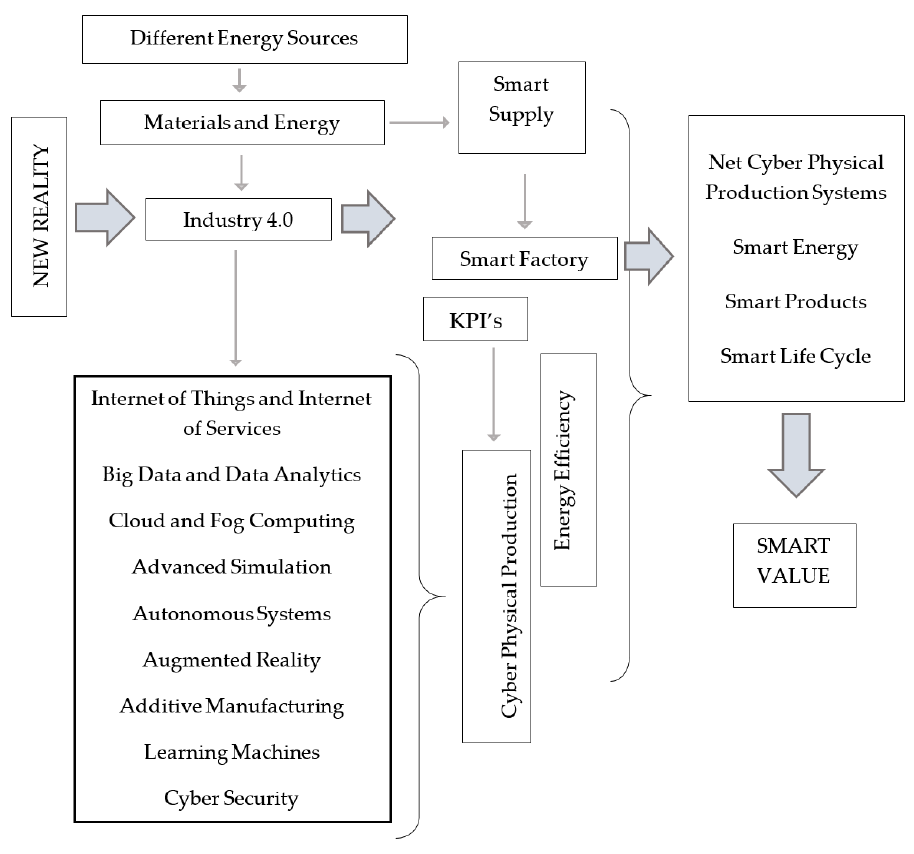
Figure 1. Industrial space and environment 4.0 for energy efficiency.